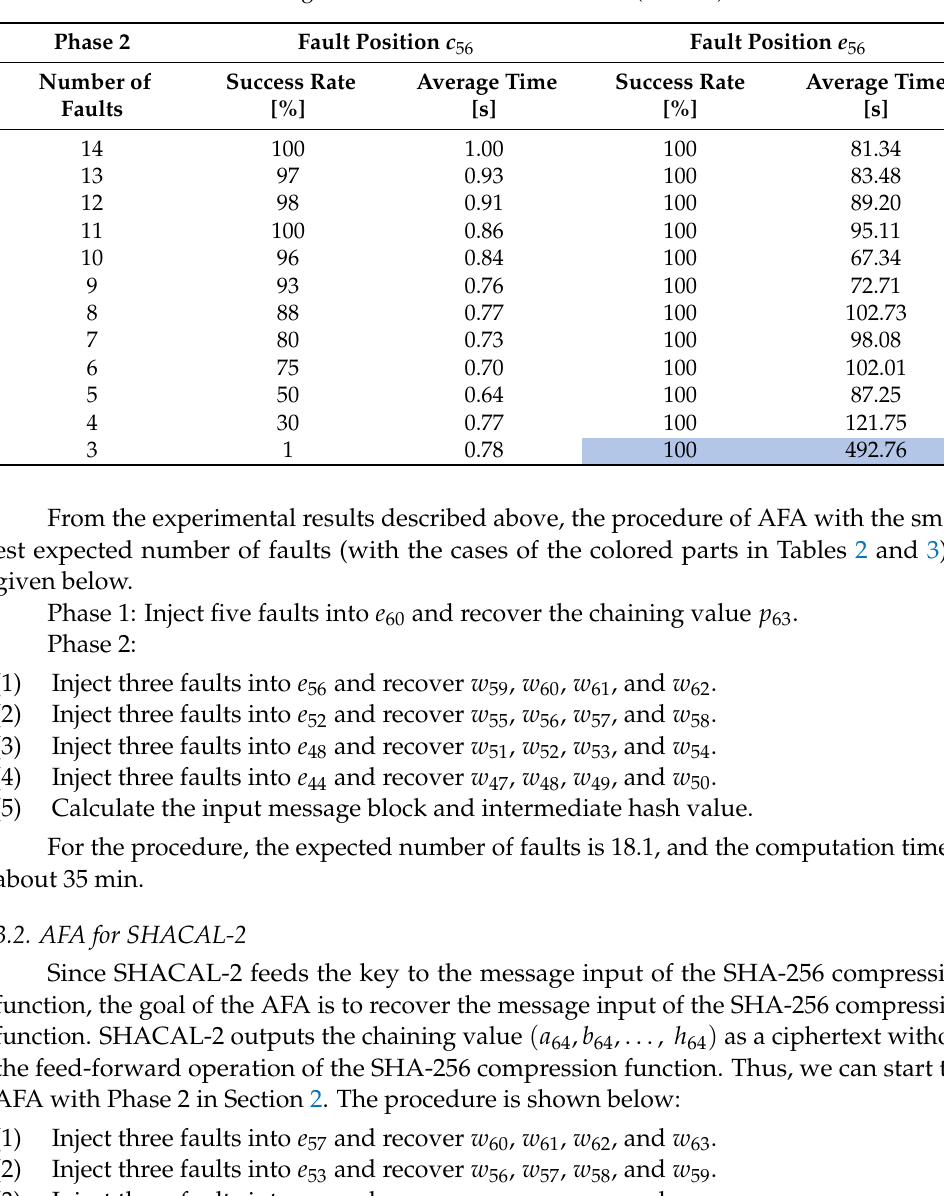
Table 3. Success rate and average time for each number of faults (Phase